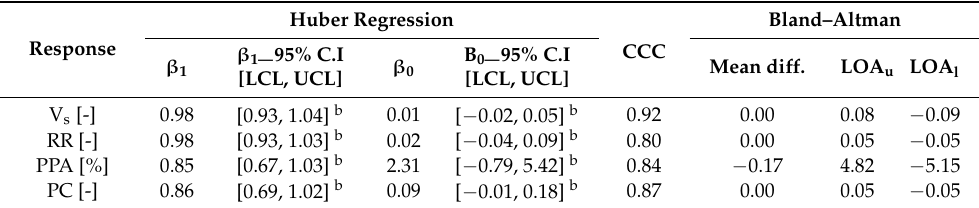
Figure 12. Regression plot and Bland-Altman plot for V s . Table 7. Method comparison metrics for structural